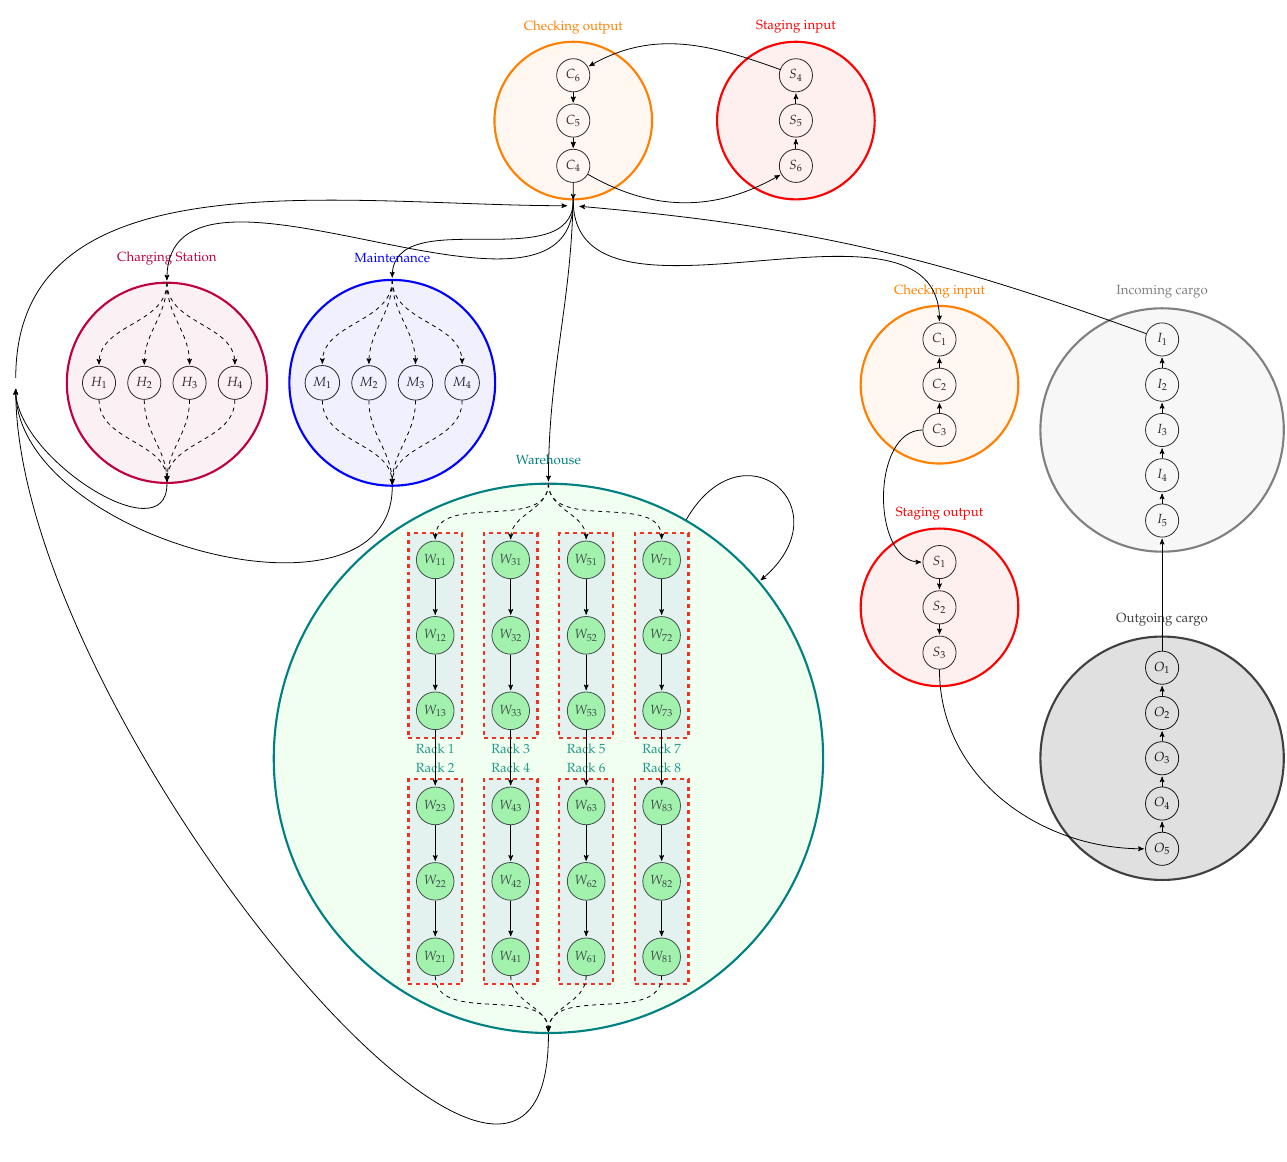
Figure 6. State machine of warehouse logistic process [27].